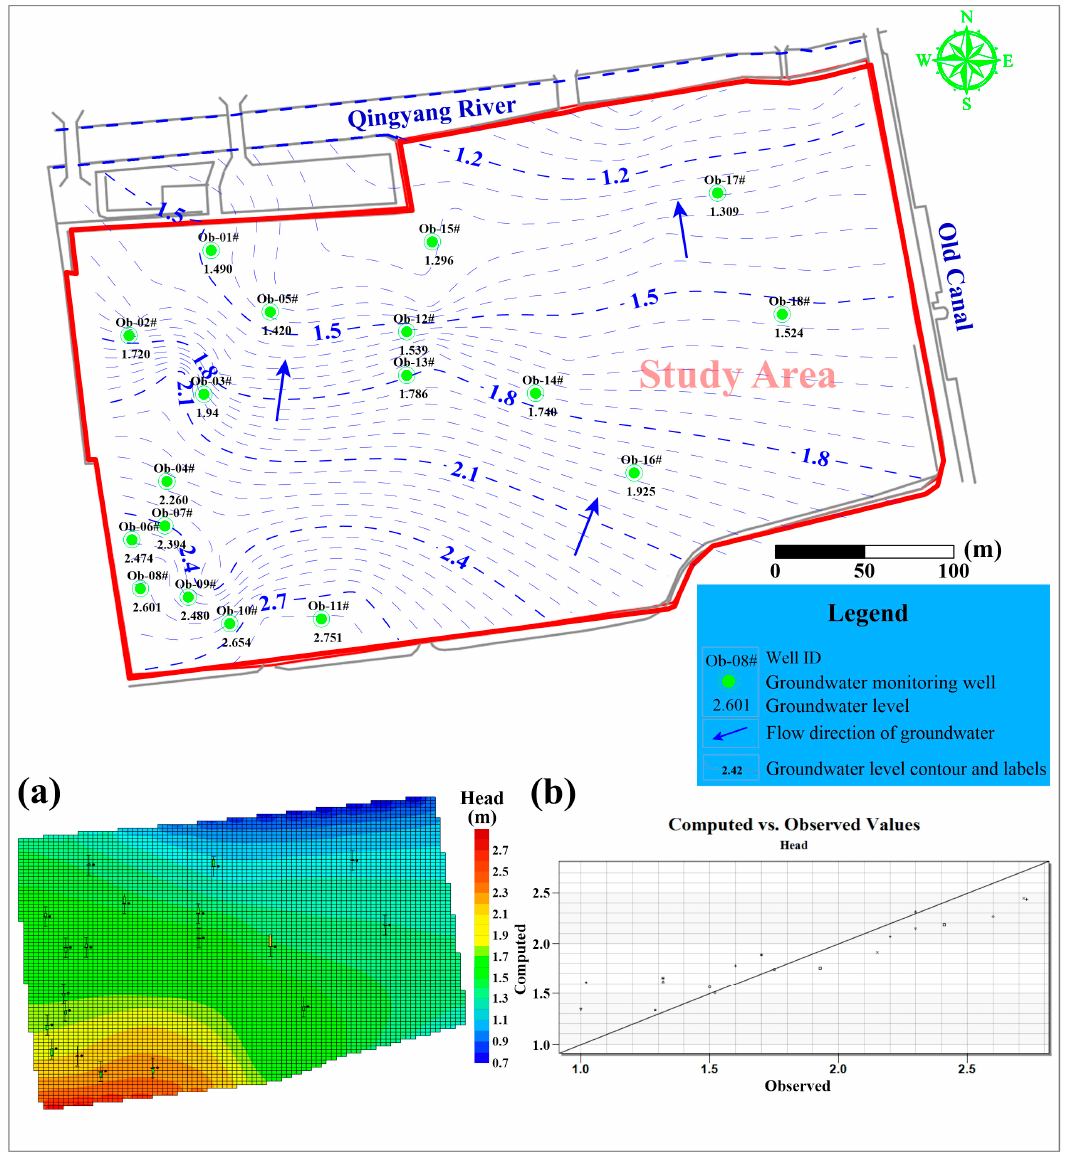
Figure 5. Groundwater levels of the study site; ( a ) contour of the simulated and observed water heads of the microconfined aquifer; and ( b ) the comparison between the computed and observed values.